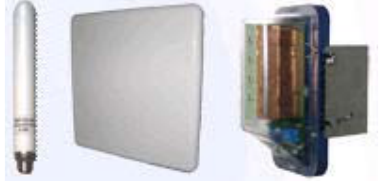
fig. 9. Symeo antennas and transmitter, picture from